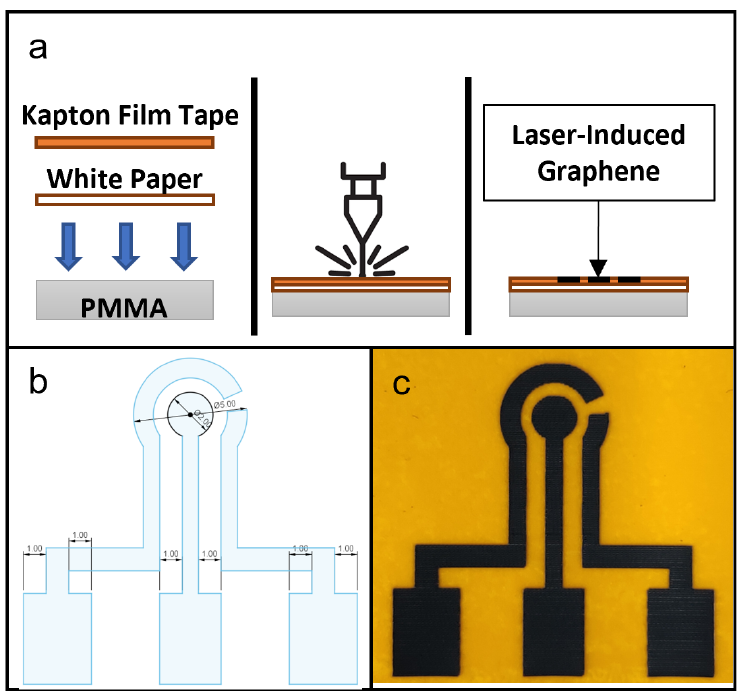
Figure 1. ( a ) Schematic of fabrication of laser-induced graphene (LIG) showing in cross-section the setup of materials, laser ablation process and finished product. ( b ) CAD drawing of a LIG electrode design for this study. ( c ) Photograph of a produced LIG electrode unit, with counter electrode (CE) on the left, working electrode (WE) in the center and reference electrode (RE) on the right.